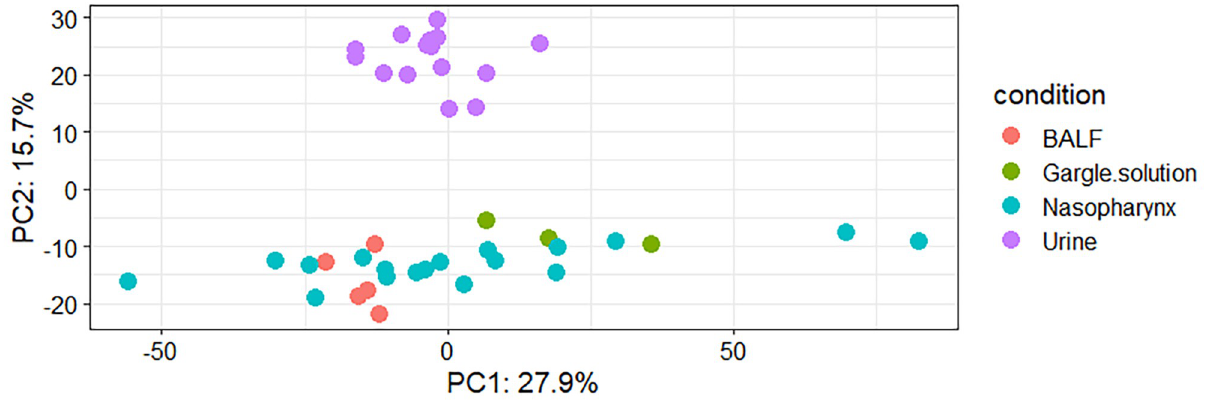
Fig 1. Principal component analysis showing the clustering of proteomes obtained from bronchoalveolar lavage fluid, gargle solution, nasopharynx, and urine samples. The patients sample groups are shown on the key to the right.